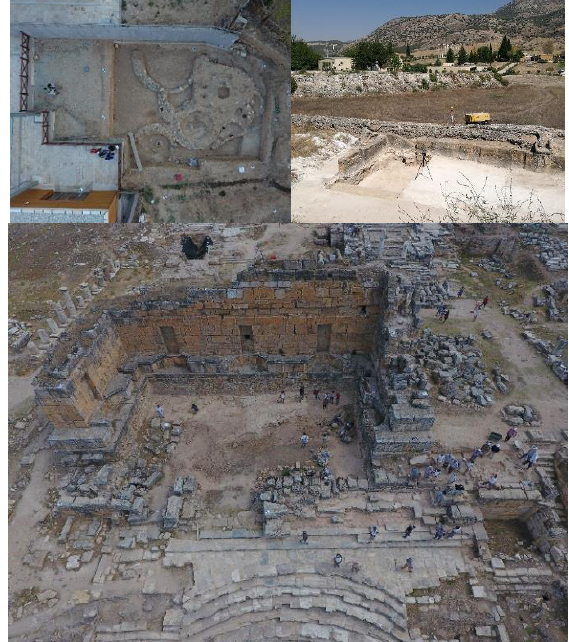
Figure 1. (above left) A nadir view of the Phrygian village site, wedged between the reception and conveying facilities of tourists. (above right) The basin for textiles dyeing, leaning against one of the limestone channels formed with the human intent to distribute the water in the city. (below) Bird eye view of the outstanding ruins of the nymphaeum of the sanctuary of Apollo. Teams at